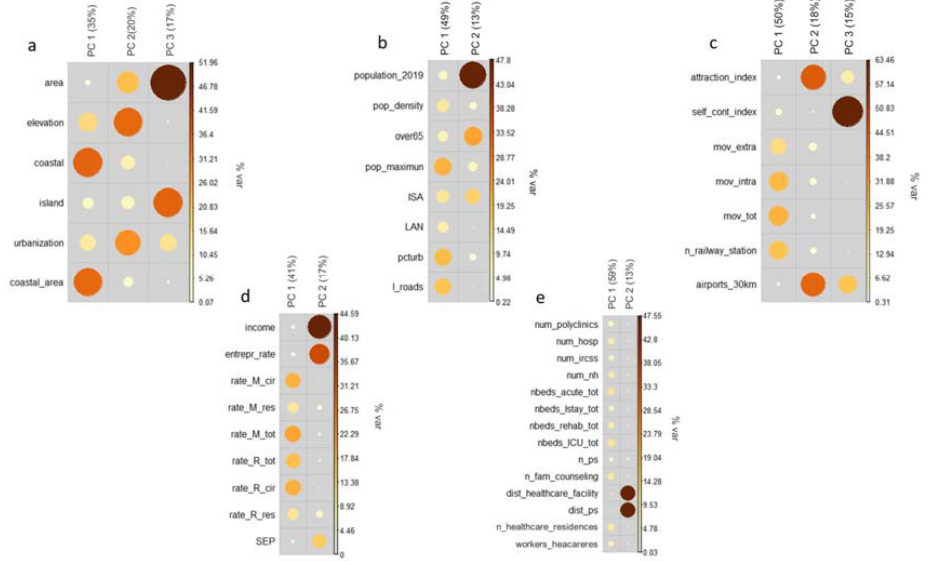
Figure 2. Results of the principal component analysis (PCA); the contributions of individual contextual covariates on the selected components are displayed for the five dimensions (geographic characteristic ( a ), demographic and anthropogenic characteristics ( b ), mobility ( c ), socio-economic and health status of the population ( d ), availability of health care ( e )). Variable labels are listed in Table 1.